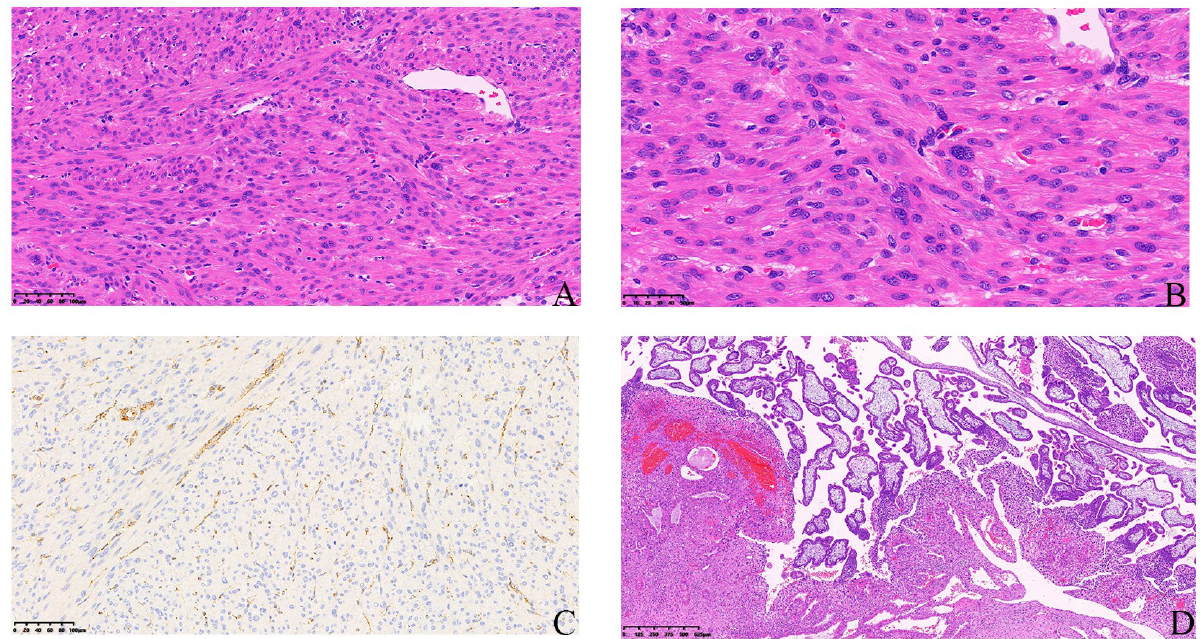
Figure 4. Results of immunohistochemistry of uterine leiomyoma with fumarate hydratase (FH) deficiency. ( A , B ) Hematoxylin-eosin staining of a uterine leiomyoma biopsy (20 × ) (40 × ). ( C ) Cells of uterine leiomyoma were negative to FH, while adjacent vascular endothelial cells and vascular smooth muscle cells were positive to FH. ( D ) Leiomyomas with